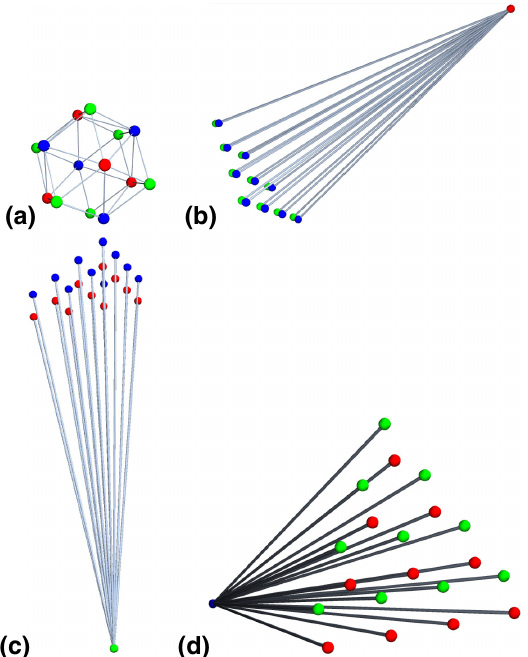
FIG. 41. Z -type gauge operators that are measured in the pro- tocol to implement code switching are associated with RG , RB , and GB edges in the lattice, illustrated for the distance d = 9 lattice. We separate the edges into 20 cases. (a) Edges connect- ing interior vertices are classified by color and the vector from one vertex to the other. (b)–(d) Other edges are classified by incident